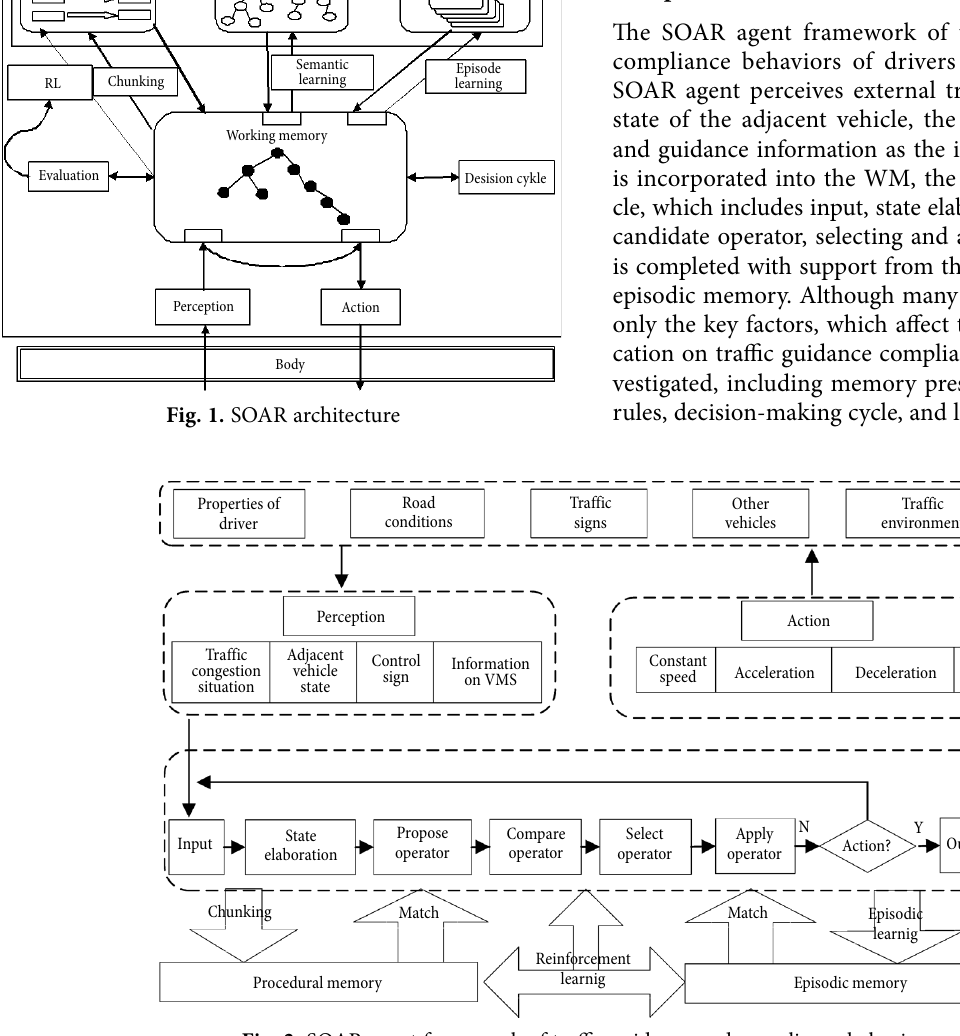
Fig. 2. SOAR agent framework of traffic guidance and compliance